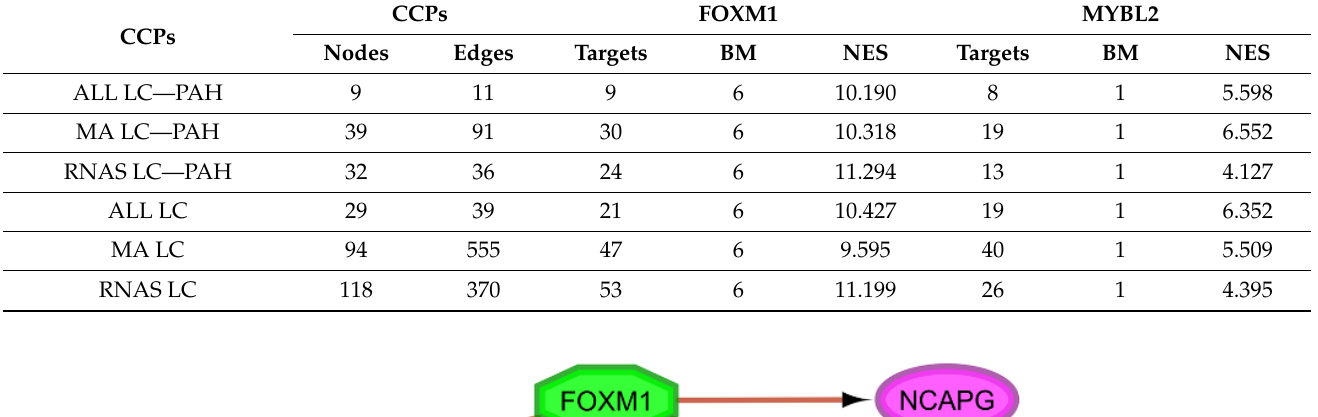
440 Figure 2. Correloplot of the mRNA expression correlation of the most frequently dysregulated tran- scription factors in every lung cancer type: ( A) NSCLC and ( B) SCLC. In blue are the negatively correlated TFs, and in red are the positively correlated TFs. Table 3. Common connection patterns (CCPs) of lung cancer (LC) (microarrays (MA) and RNA-Seq